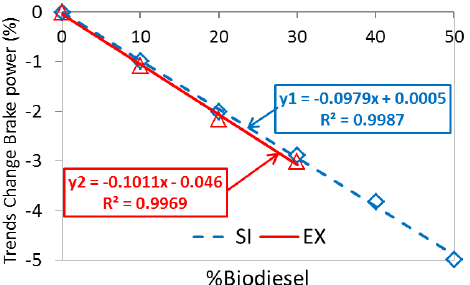
Figure 9. Trend of capacity changes according to biodiesel blend ratio of simulation (SI) and ex- periment (EX).